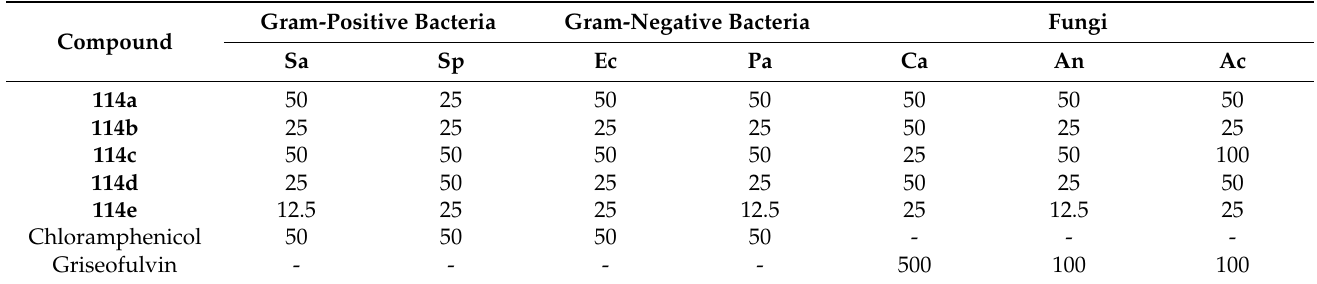
Table 5. Antimicrobial activity (MIC values in µg mL − 1 ) of analogues 114a − 114e.